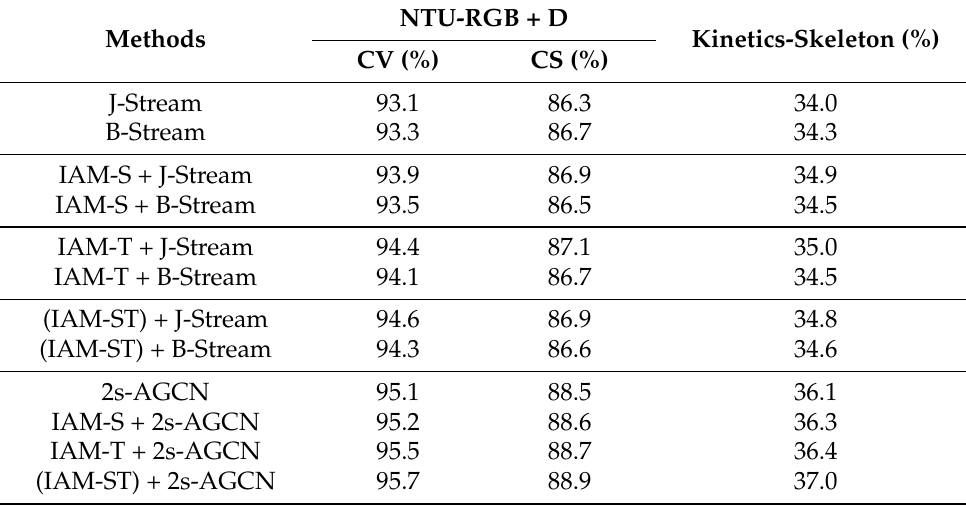
Table 2. Effectiveness analysis of importance attention module in NTU-RGB + D and